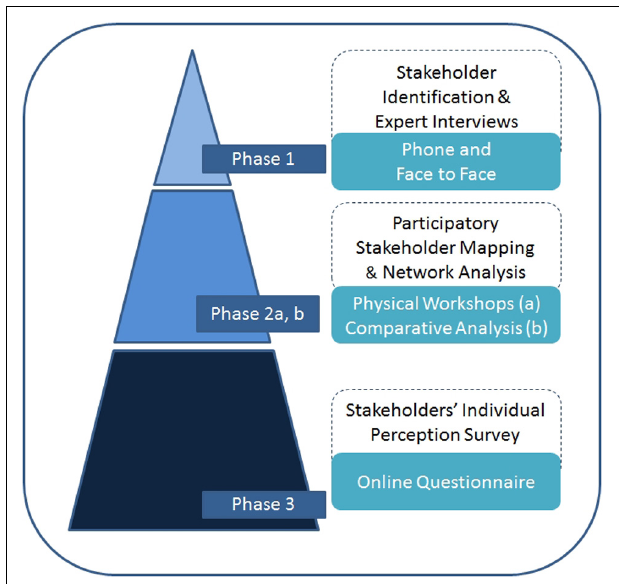
FIGURE 1 | Structure of the research concept.